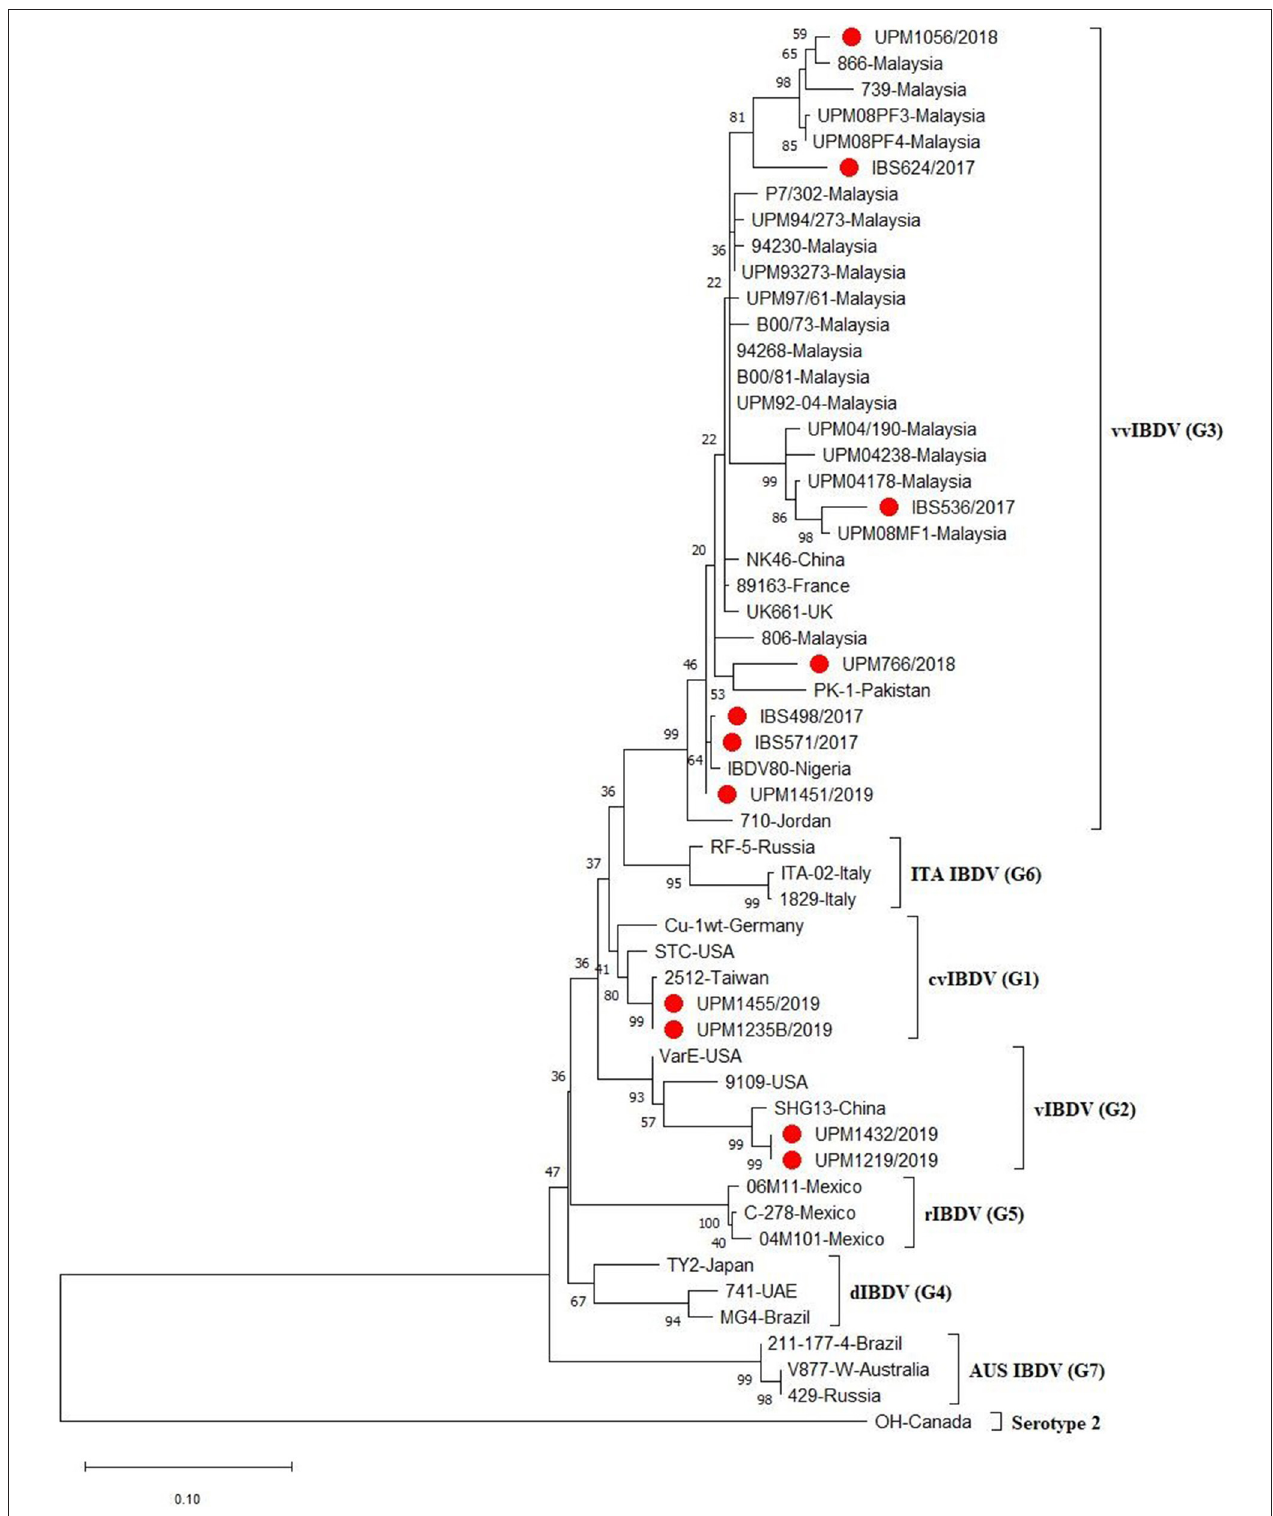
FIGURE 2 | Maximum Likelihood-based Phylogenetic tree of the hypervariable region of IBDV using 433 nucleotides fragment with the Kimura 2-parameter model. Each genogroup and the serotype 2 strains are indicated with different colors. Bootstrap = 1,000 replicates. The filled circles indicate strains identified in this study.